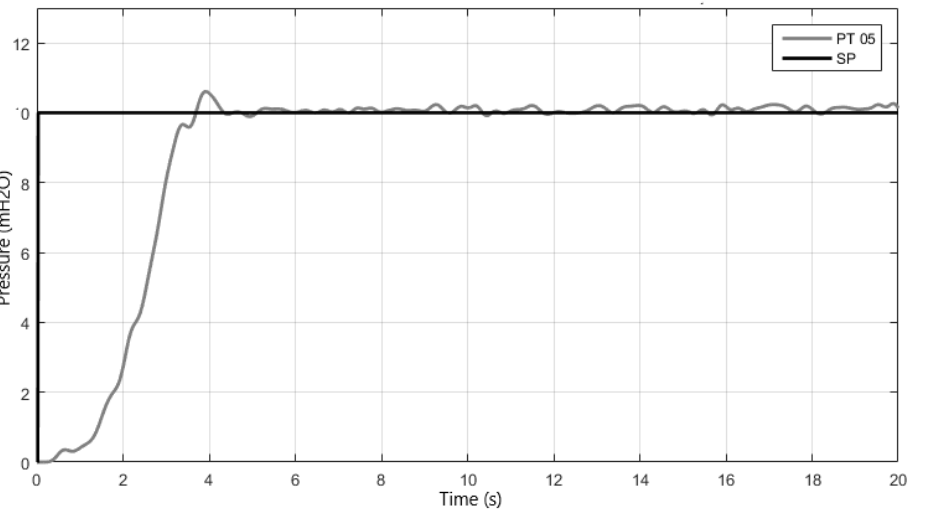
Figure 7. Relationship between the set-point and the pressure for the step response of the proposed fuzzy